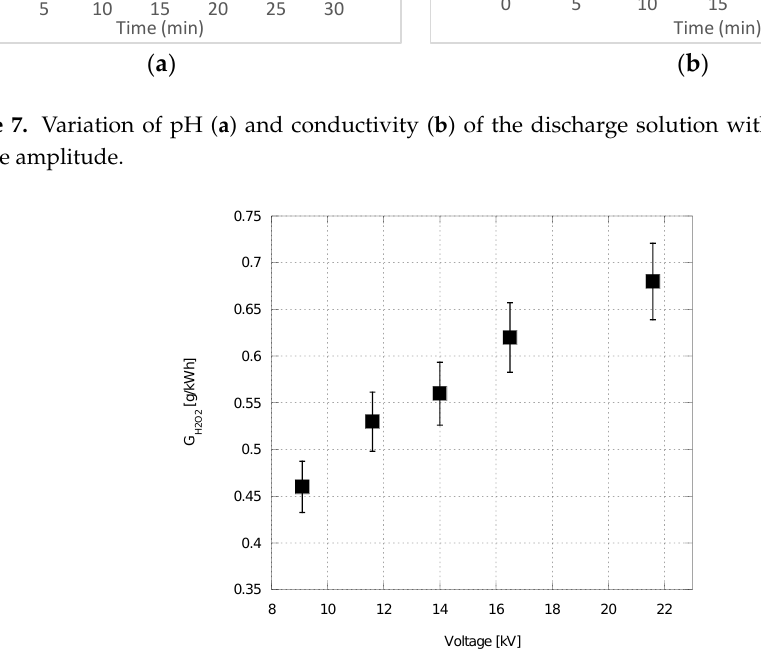
Figure 8. Production yield efficiency of H 2 O 2 (G H2O2 in g/kWh) for different voltage amplitudes of streamer discharge plasma at water surface.